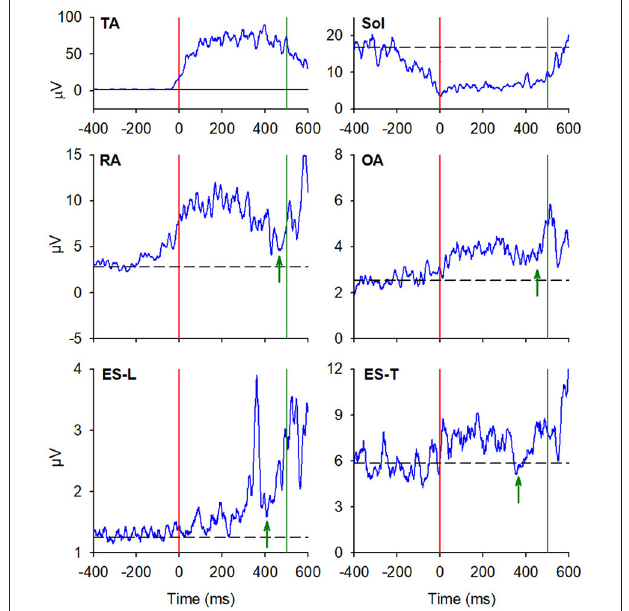
FIGURE 5 | EMG activity in the prime mover (TA and Sol) and trunk postural muscles (RA, OA, ES-L, and ES-T) recorded on the trailing left side of the same representative subject of Figures 2 , 3 . Vertical red lines at time 0 mark the onset of the backward CoP shift while vertical green lines mark the heel-off. Green arrows in each plot mark the onset of the second changes in EMG activity that, once more, follow the CoP onset and precede the heel-off. Black dashed lines represent the average muscle activity in the baseline time